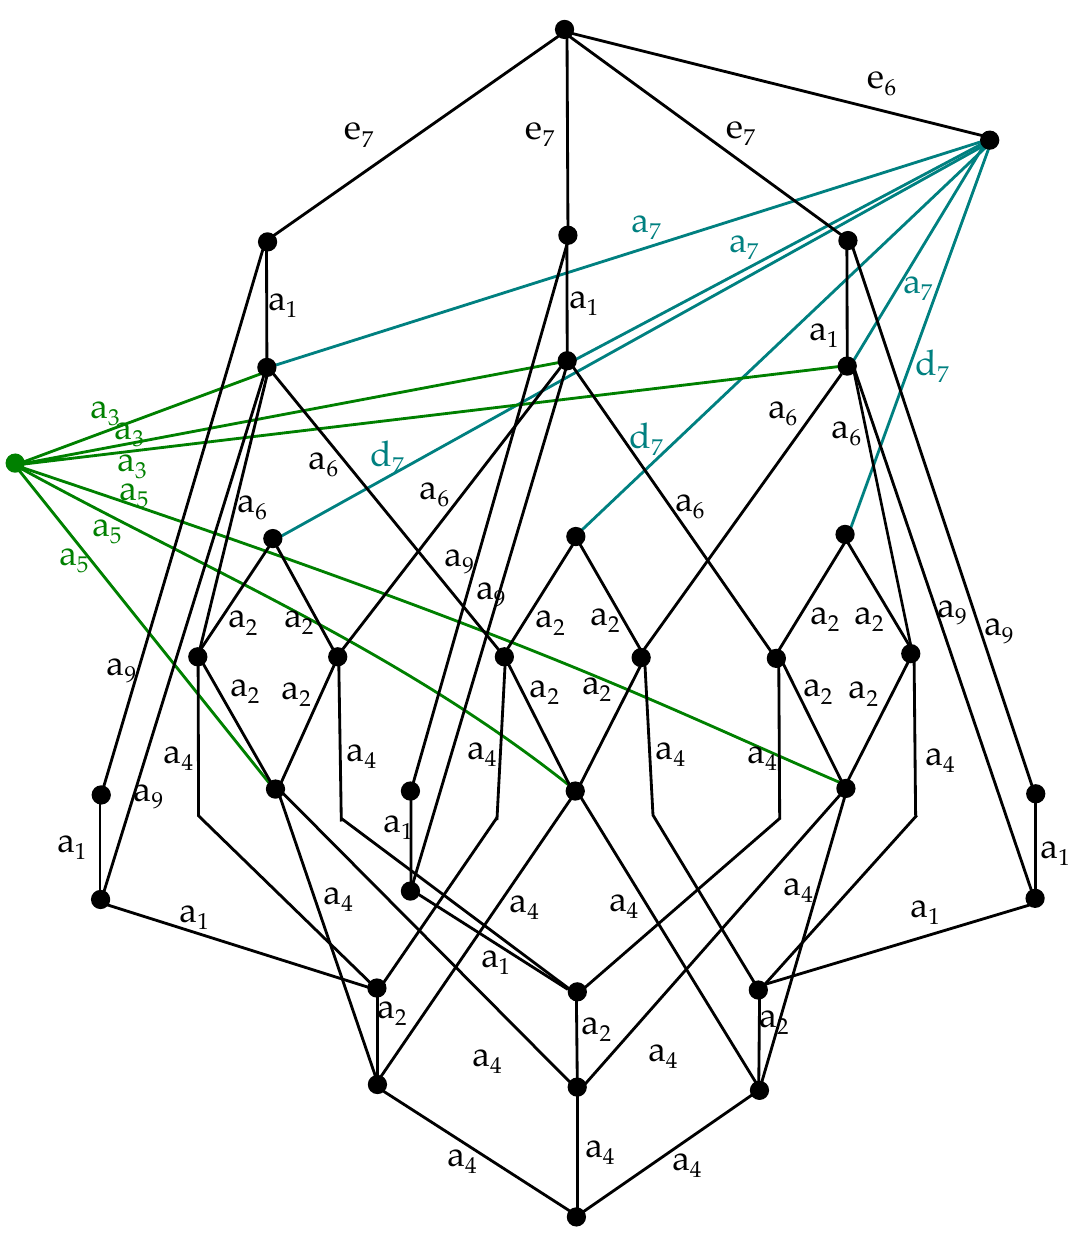
Figure 25 . The Hasse diagram for T 5 . The colors in this (cid:12)gure are simply there for ease of